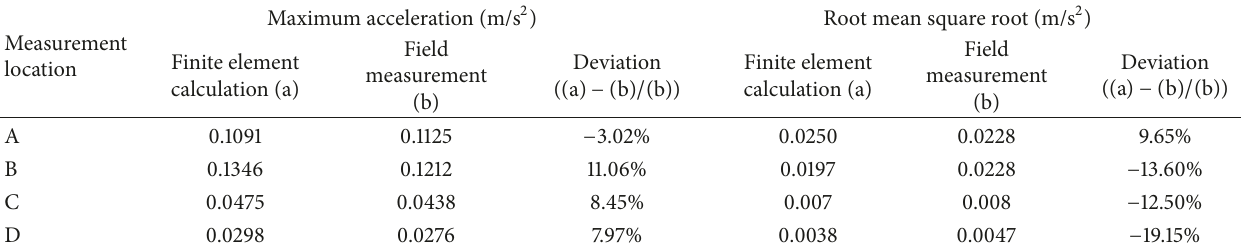
Table 7: Comparison of the maximum acceleration and root-mean-square responses obtained from the finite element calculation and field